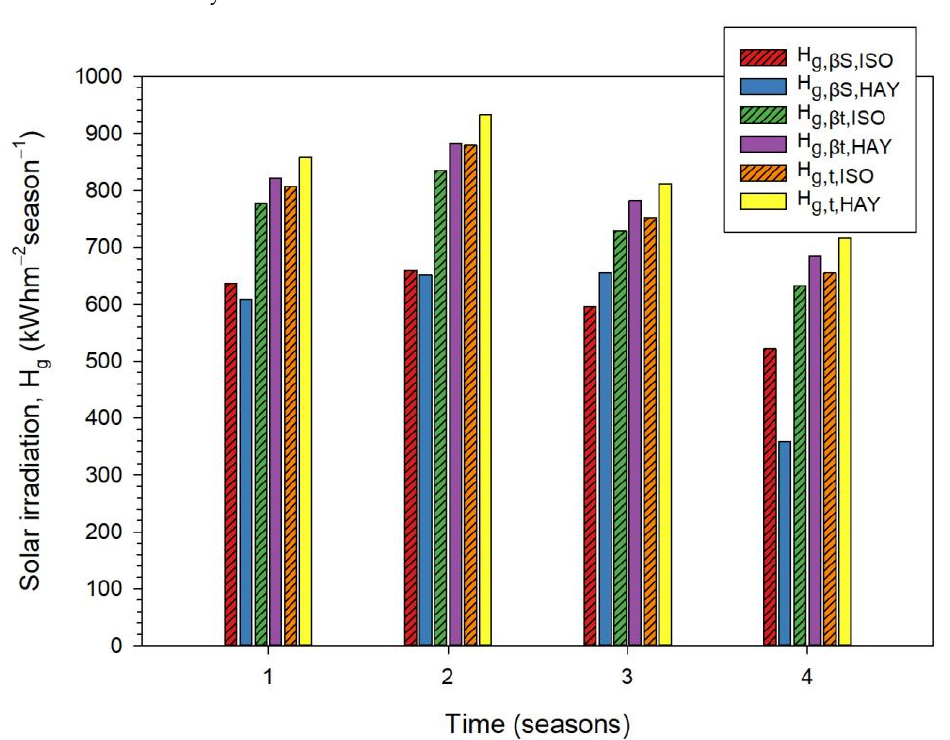
Figure 7. Seasonal solar energy yields, H g , averaged across the 82 sites in Saudi Arabia and the period 2005–2016 under all-sky conditions. The values are shown for the 3 solar system configuration modes and both ISO- and HAY-modelled results. The shaded bars indicate the ISO estimates, and the solid bars the HAY ones. The seasons on the x-axis are spring (1) to winter (4).